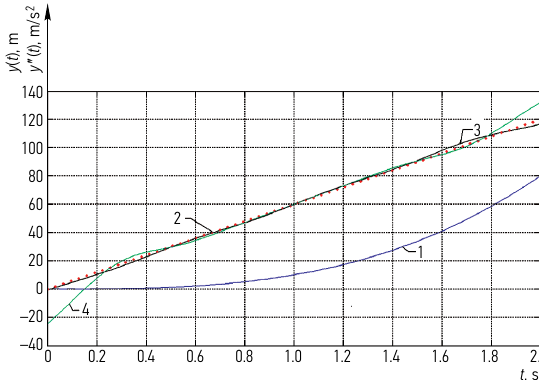
Fig. 3. Second derivatives (car accelerations), numerically calculated by using the classical and offered methods from the input signal with the standard deviation ( )  σ =   0.05 n t of input Gaussian signal-independent noise: 1 – input signal with the noise to differentiation; 2 – theoretical second derivative; 3 – second derivative, numerically calculated by using the offered method; 4 – second derivative, numerically calculated by using the classical method